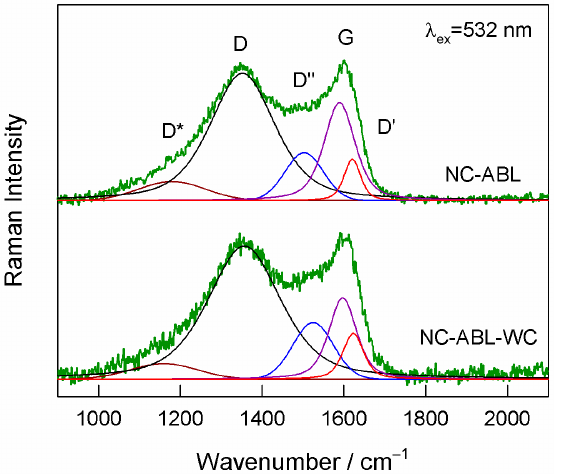
Figure 3. Raman spectra of the NC-ABL and NC-ABL-WC carbon samples using an excitation wavelength of 532 nm (0.2 mW). The fitted Gaussian (D* and D ″ ) and Lorentzian–Gaussian (D, G, and D ′ ) form components are also shown.